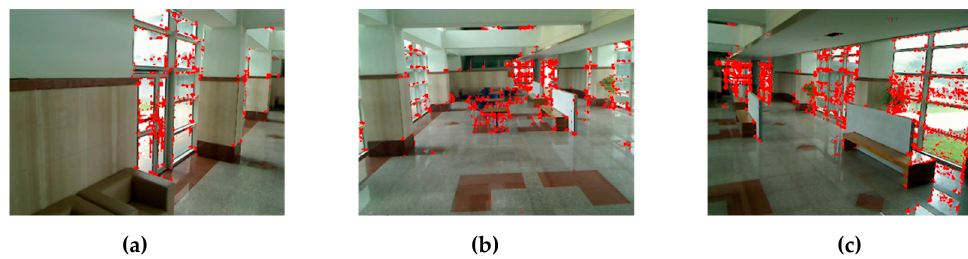
Figure 4. Extract Corner Features from background images. ( a ) Vision of the camera capturing left hand side. ( b ) Vision of the camera capturing the front. ( c ) Vision of the camera capturing right hand side.